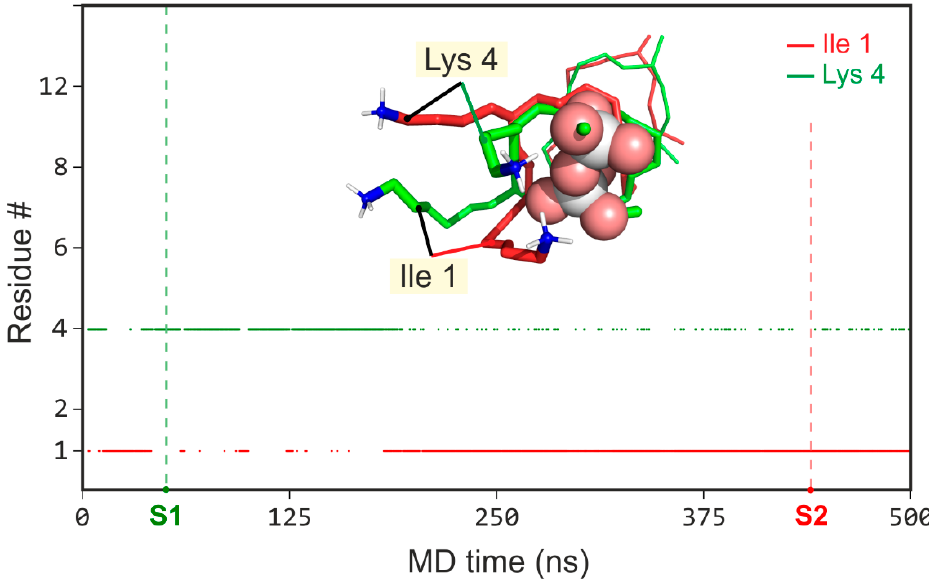
Figure 3. The alternate charge in the gallidermin’s DMPPi binding site. The main graph is a time- dependent H-bonding pattern between DMPPi ion and the charged groups of gallidermin 1–12 : Ile1 ( red ) and Lys4 ( green ). Inset : zoomed-in spatial structure of two binding regimens in the major bound state of galligermin 1–12 : S1 ( green )— ε -NH 3+ -group of Lys4 binds to DMPPi; S2 ( red )— N -terminus (NH 3+ -group of Ile1) binds to DMPPi. DMPPi is shown with spheres and sticks , wherein oxygen— red , phosphorus— white , carbon— green . For epidermin 1–12 , the same applies.